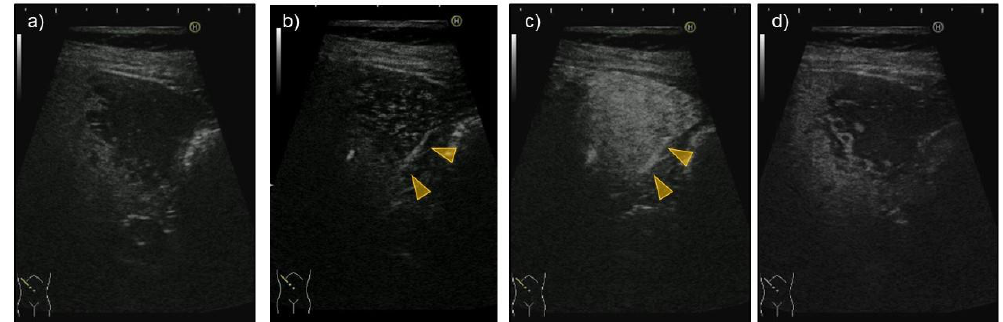
Figure 2. The tumor lesion at segment S5 in the liver was hypo-echoic on B-mode ultrasonography ( a ), through which a penetrating vessel was detected ( b , arrowheads), which was enhanced in the arterial phase ( c , arrowheads). The vessel was evident in the Kupffer phase ( d ) on enhanced ultrasonography using Sonazoid.